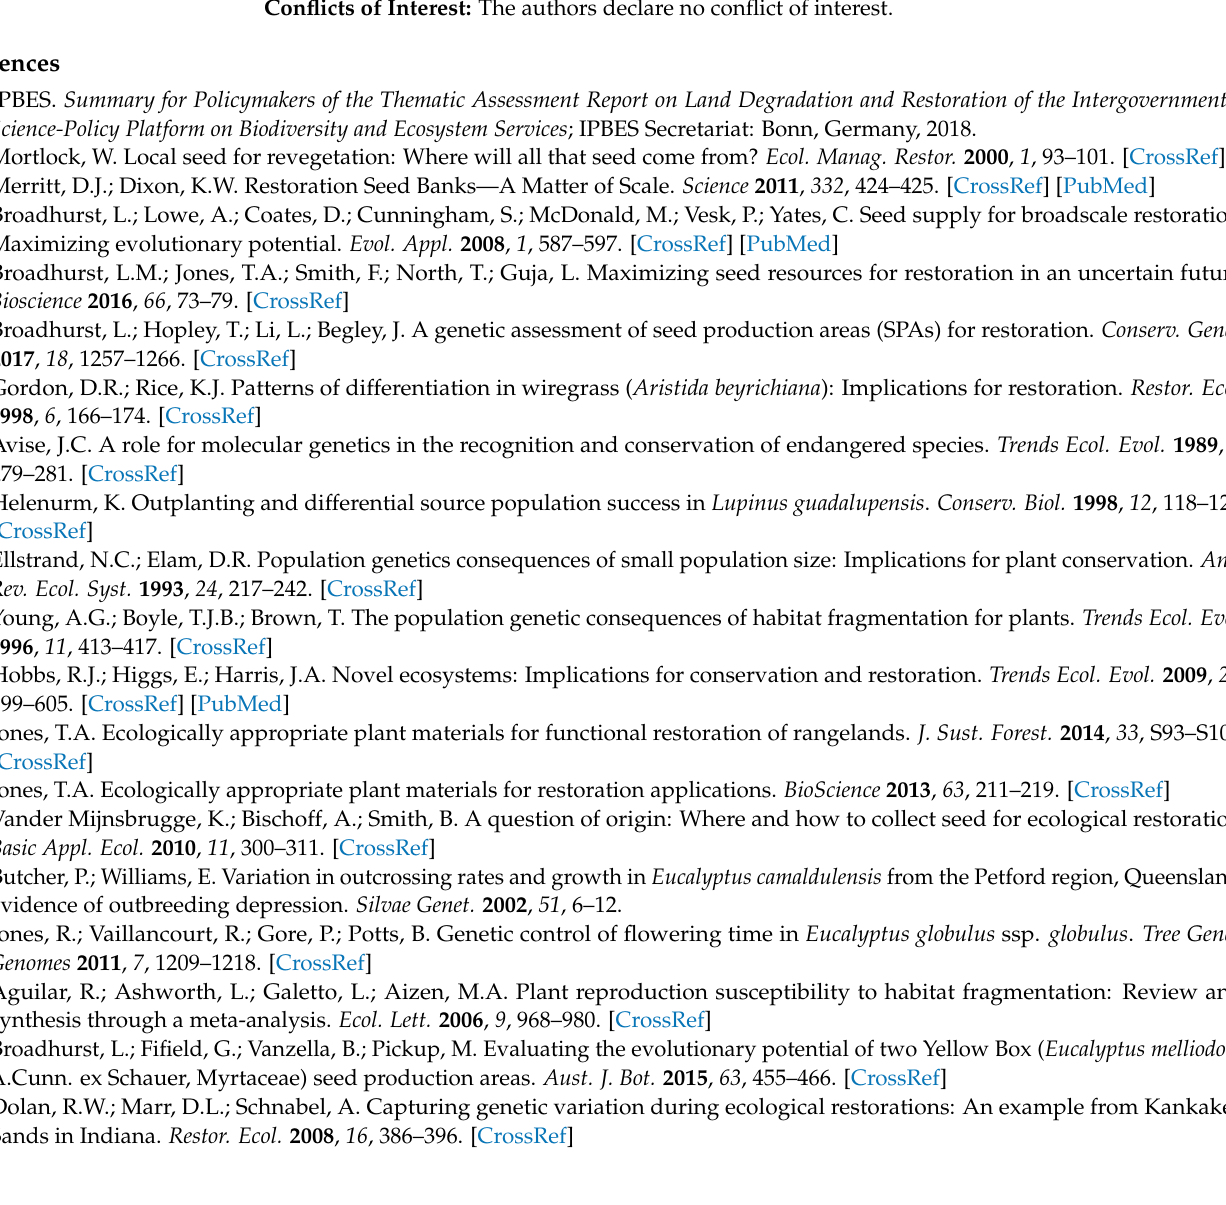
Table S3: Significant p -values for each locus pair across all Banksia marginata populations based